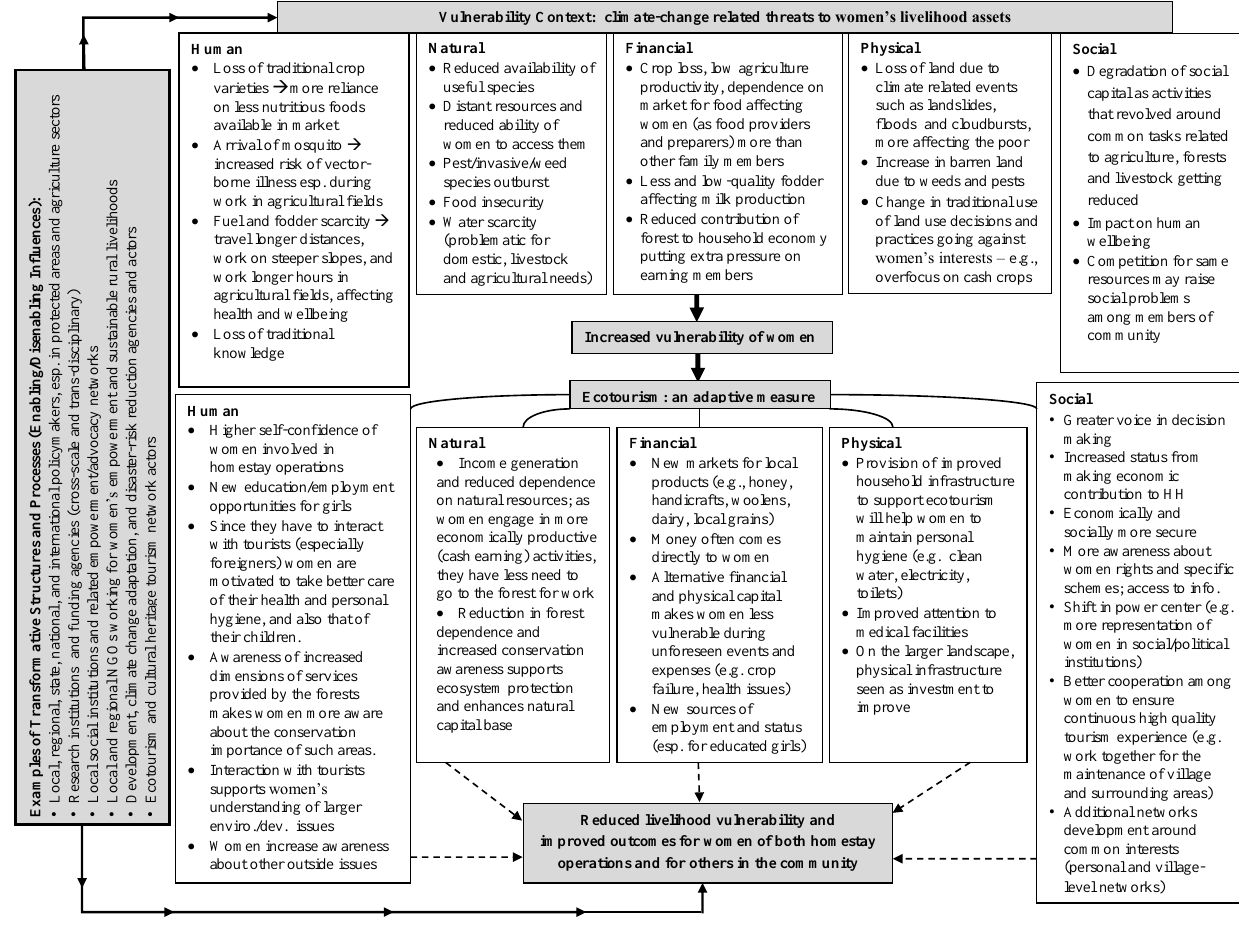
Figure 3. Application of sustainable livelihoods (SL)